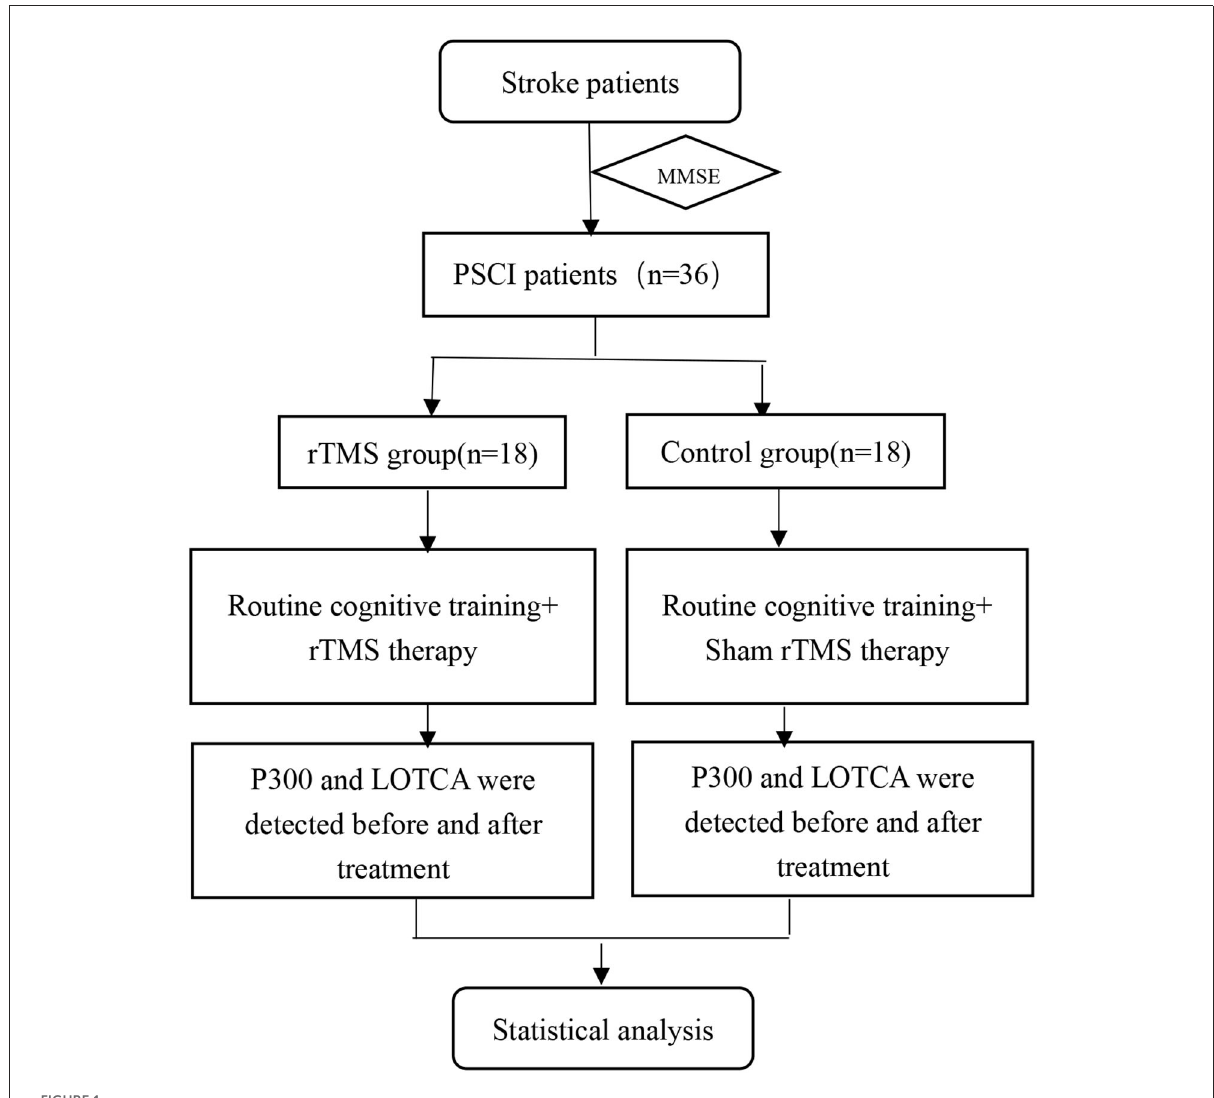
FIGURE1 Schematic representation of the treatment design.